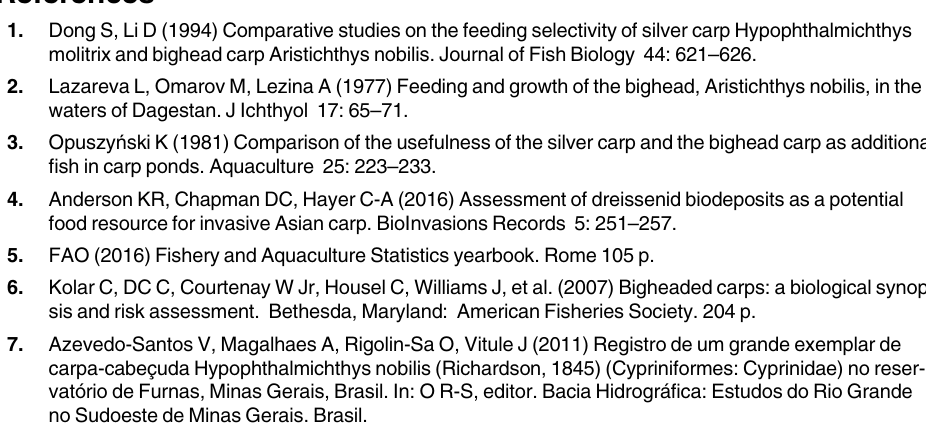
S3 Table. Thermal and hydraulic thresholds, egg release dates and daily discharges of the Contuga and Berra siphons as well as of the Po river (data underlying Fig 3).